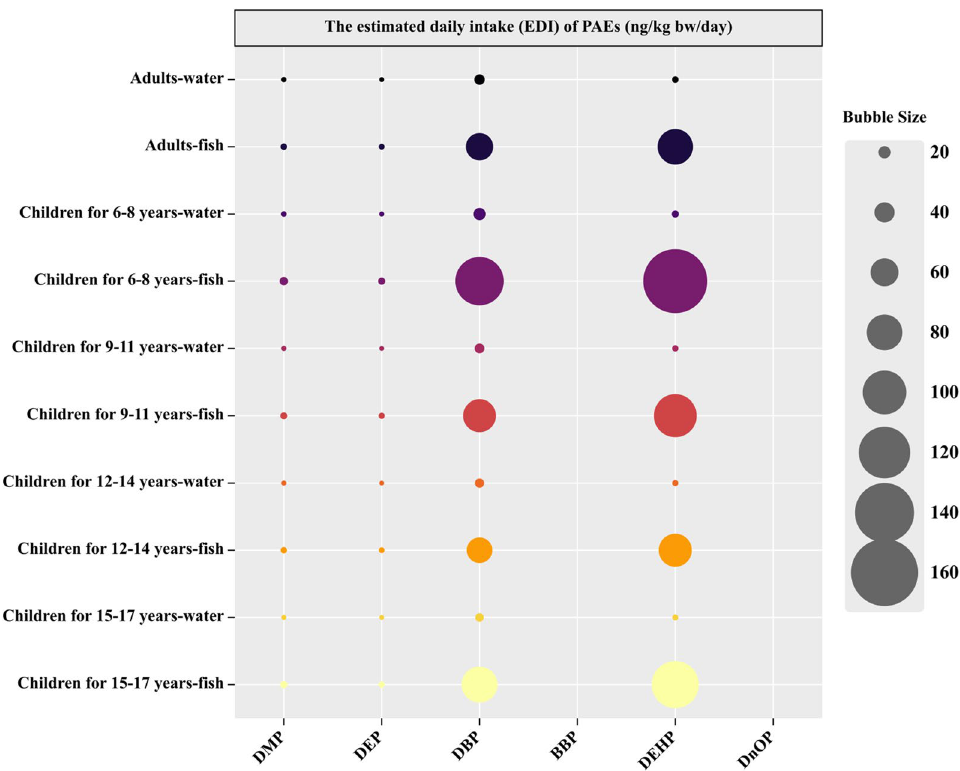
Fig. 5 The estimated daily intake (EDI) of PAEs per unit body weight exposure to fish and water for adults and